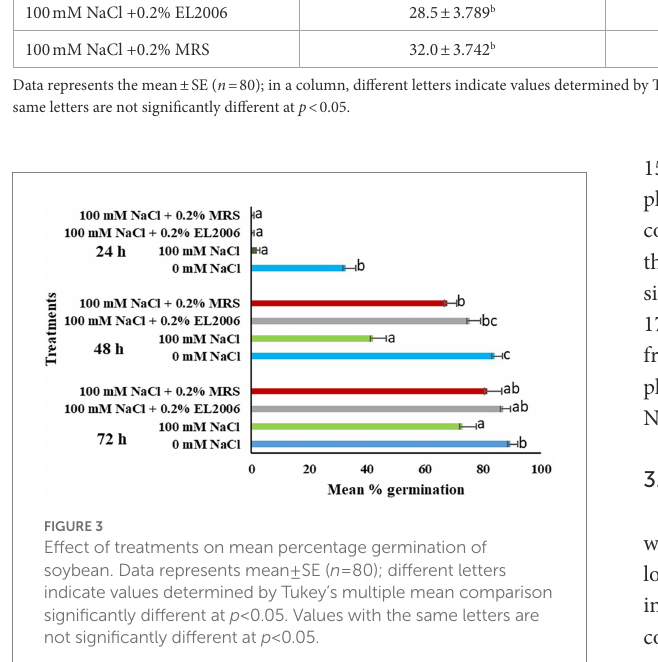
( p < 0.0001). Treatment with 100 mM NaCl +0.2% EL2006